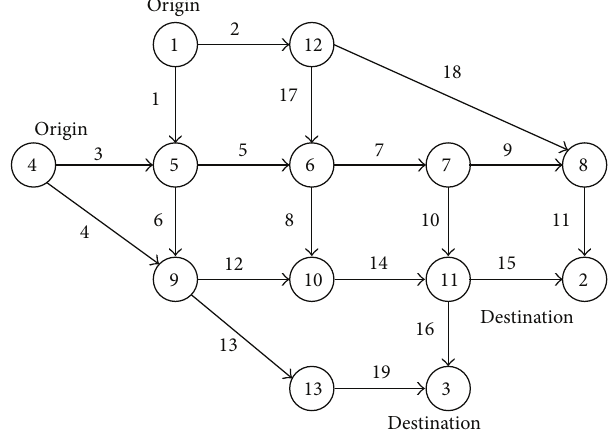
Figure 2: Nguyen-Dupuis network used in the example.